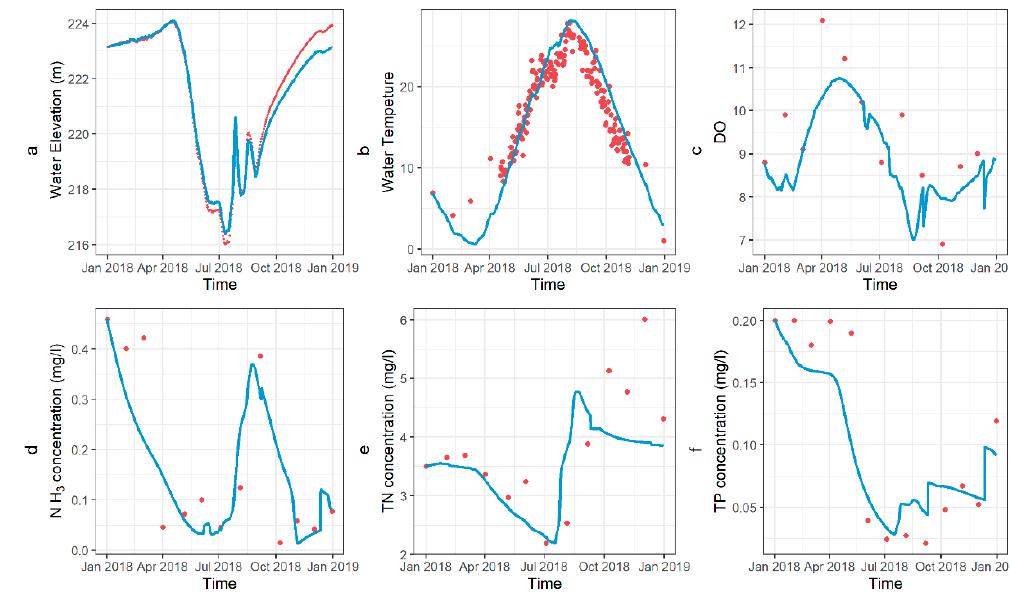
Figure 6. Measured (red dots) and LAKE2K simulated (blue lines) water quality variables (panel ( a ): water elevation; panel ( b ): water temperature; panel ( c ): DO concentration; panel ( d ): ammonia concentration; panel ( e ): total nitrogen concentration; panel ( f ): total phosphorous concentration).